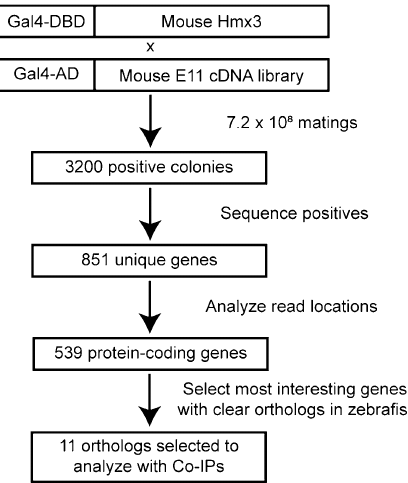
Figure 1. Isolation of novel binding partners of HMX3 with yeast two-hybrid screening. Top: Schematic representation of bait and prey constructs used in screening. Full-length mouse HMX3 fused to the Gal4 DNA- binding domain (DBD) was used as bait. A library of stage E11 mouse cDNAs fused to the Gal4 activating domain (AD) was used as prey. 7.2 × 10 8 solid plate matings were performed, yielding 3200 positive colonies. Positive prey inserts were segregated and sequenced and reads were aligned to the mouse genome, identifying 851 unique genes. After removing non-coding genes and those for which only untranslated region (UTR) or intronic sequences were recovered, 539 protein-coding sequences remained. Zebrafish orthologs of the most functionally interesting genes were selected for further analysis with